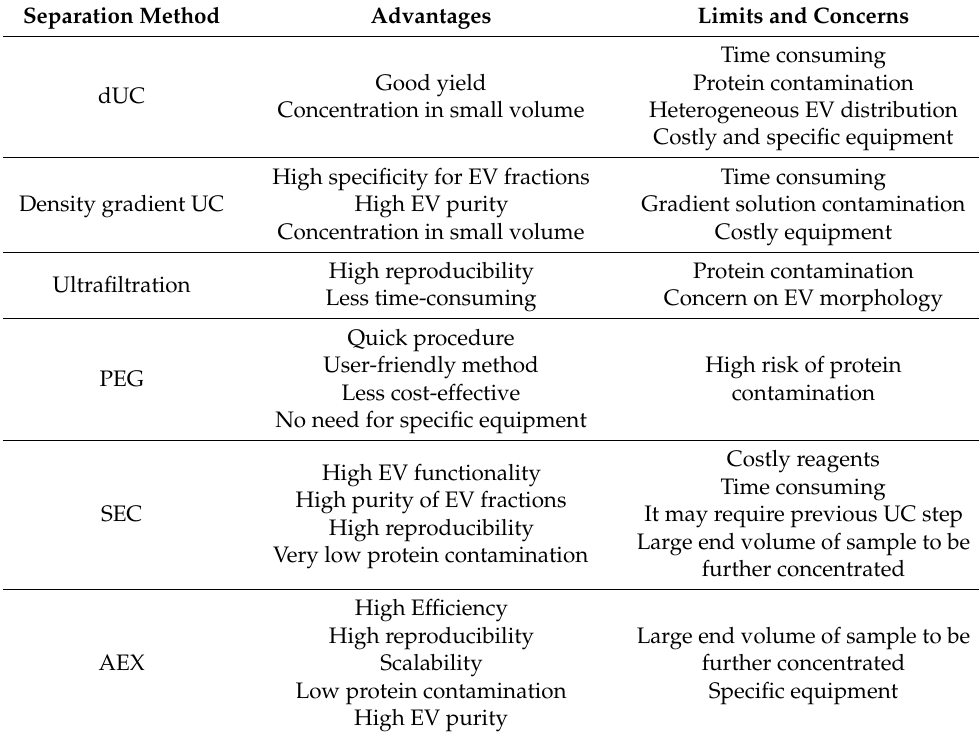
Table 1. Comparison of EV separation and concentration